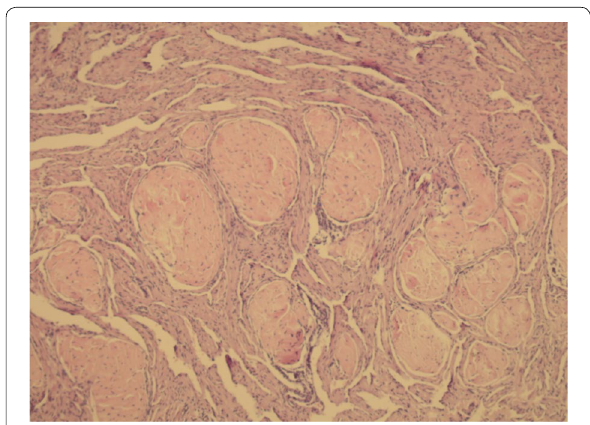
Fig. 3 H&E stained slide showing thick nerve bundles on the dorsal surface of one case ( ×